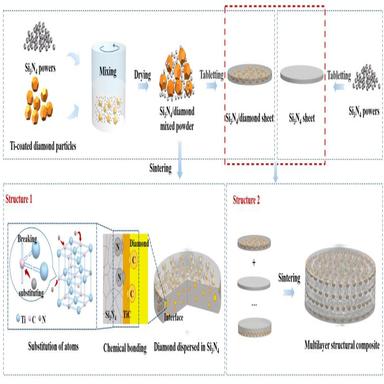
Illustration of the fabrication process and material structural design.